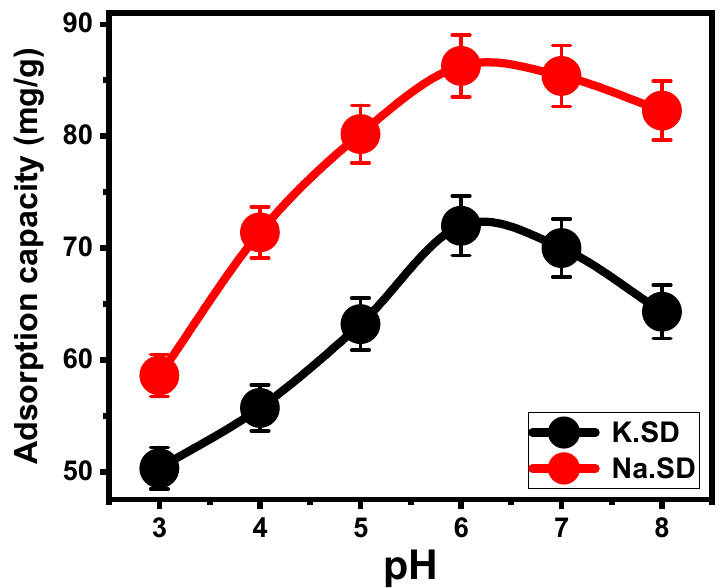
Figure 4. Effect of the solutions’ pH on the sequestration of PO 43 − of Na.SD and K.SD (100 mg L − 1 phosphate concentration, 20 °C temperature, 0.1 g L − 1 dosage, and 240 min adsorption duration).